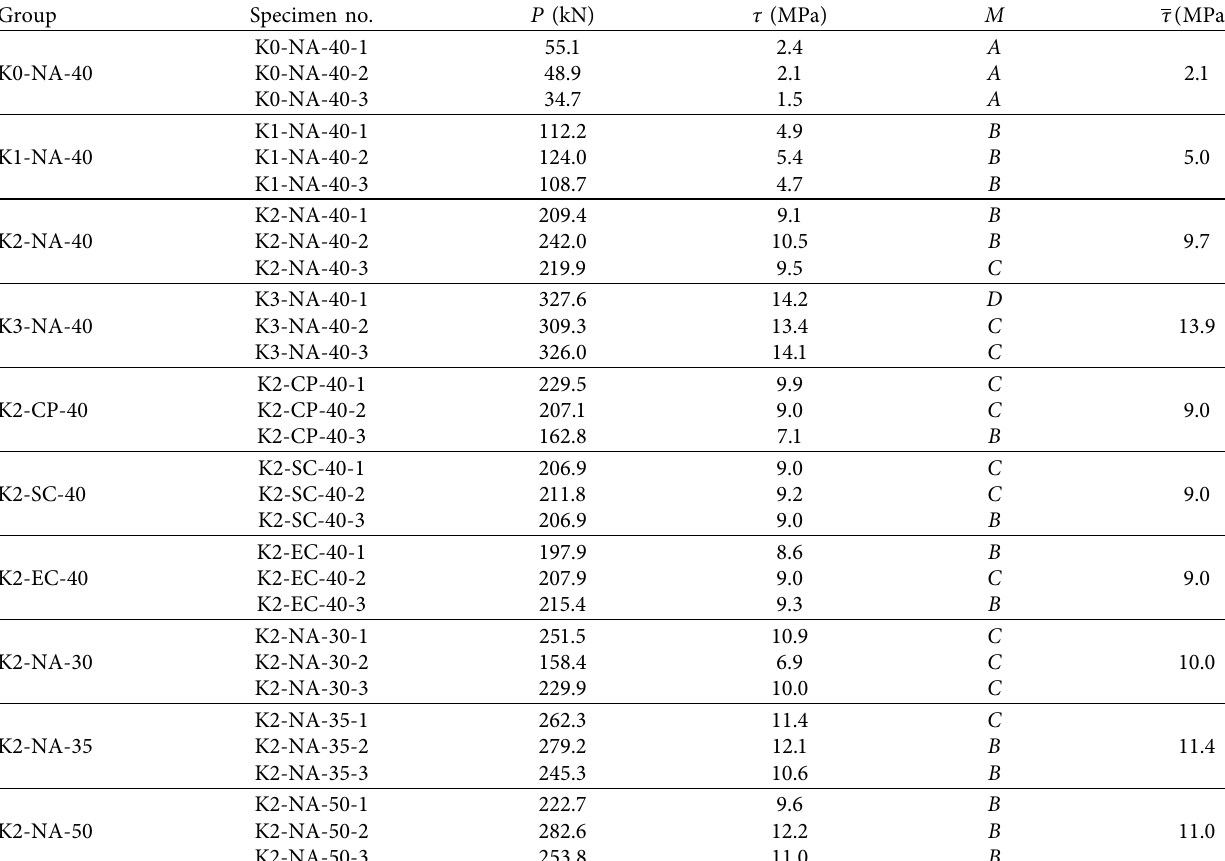
Table 5: Interfacial bond shear strength.